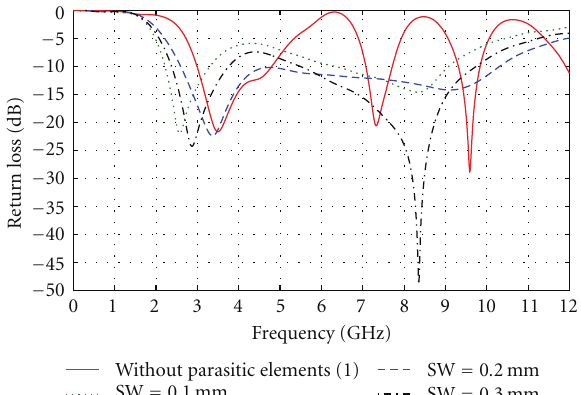
Figure 2: Simulated return losses due to width of gap (SW) between a folded feed line and a parasitic element (1).